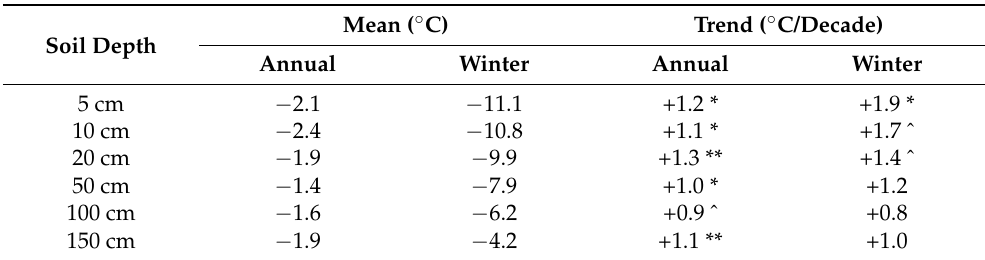
Table 1. Historic average soil temperature and the rate of change over time for soil temperature at depths from 5 to 150 cm from 1967 to 1995. Bolded numbers indicate trends that are significant at p -values less than 0.10 (ˆ), 0.05 (*) and 0.01 (**).